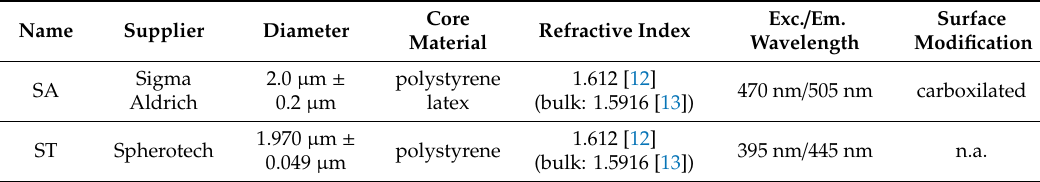
Table 1. Physical properties of the applied fluorescent microbeads.